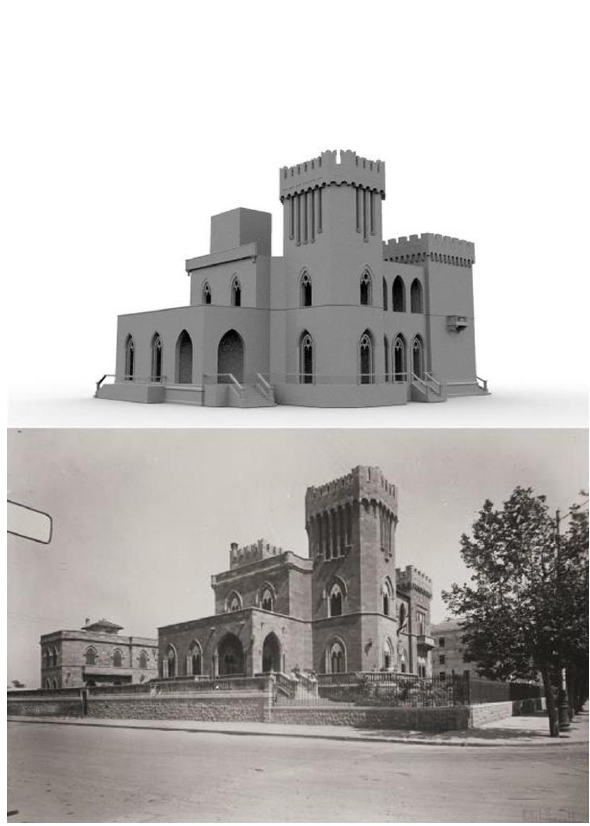
Figure 4 . Three-dimensional reconstruction and relative historical